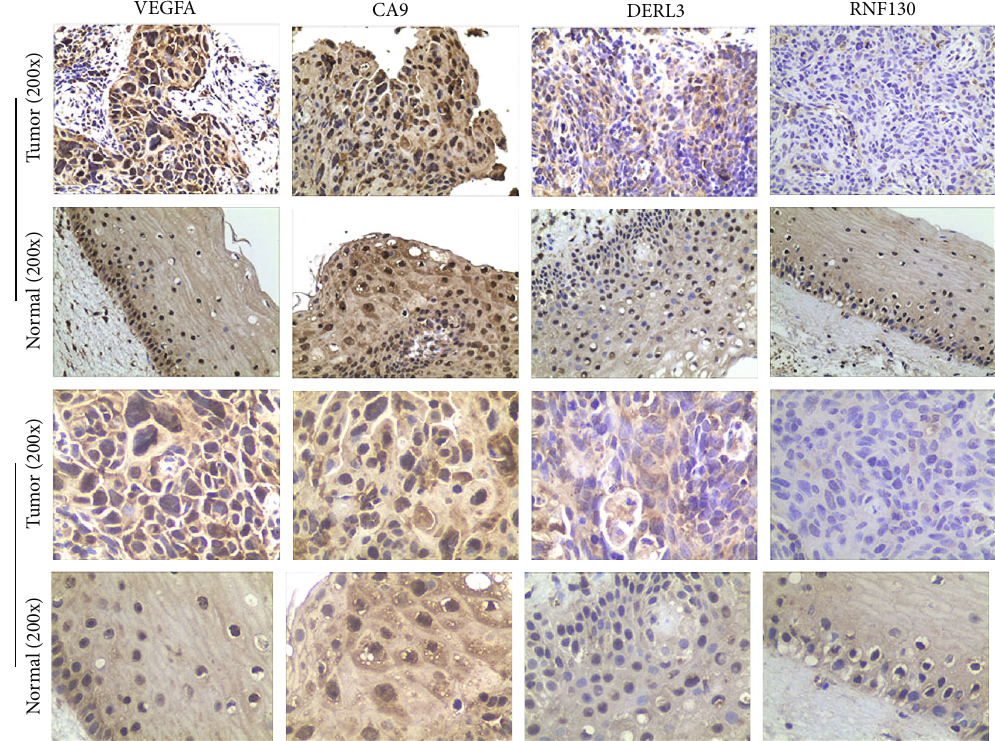
Figure 12: Protein expression of modeled genes in cervical cancer samples and normal samples. Shown in the fi gure are the results of immunohistochemistry under × 200 and × 400 magni fi cation. The results showed that the positive expression of VEGFA, CA9, and DERL3 in cervical cancer was signi fi cantly higher than that in normal samples, while the expression of RNF130 in cervical cancer was lower than that in the normal